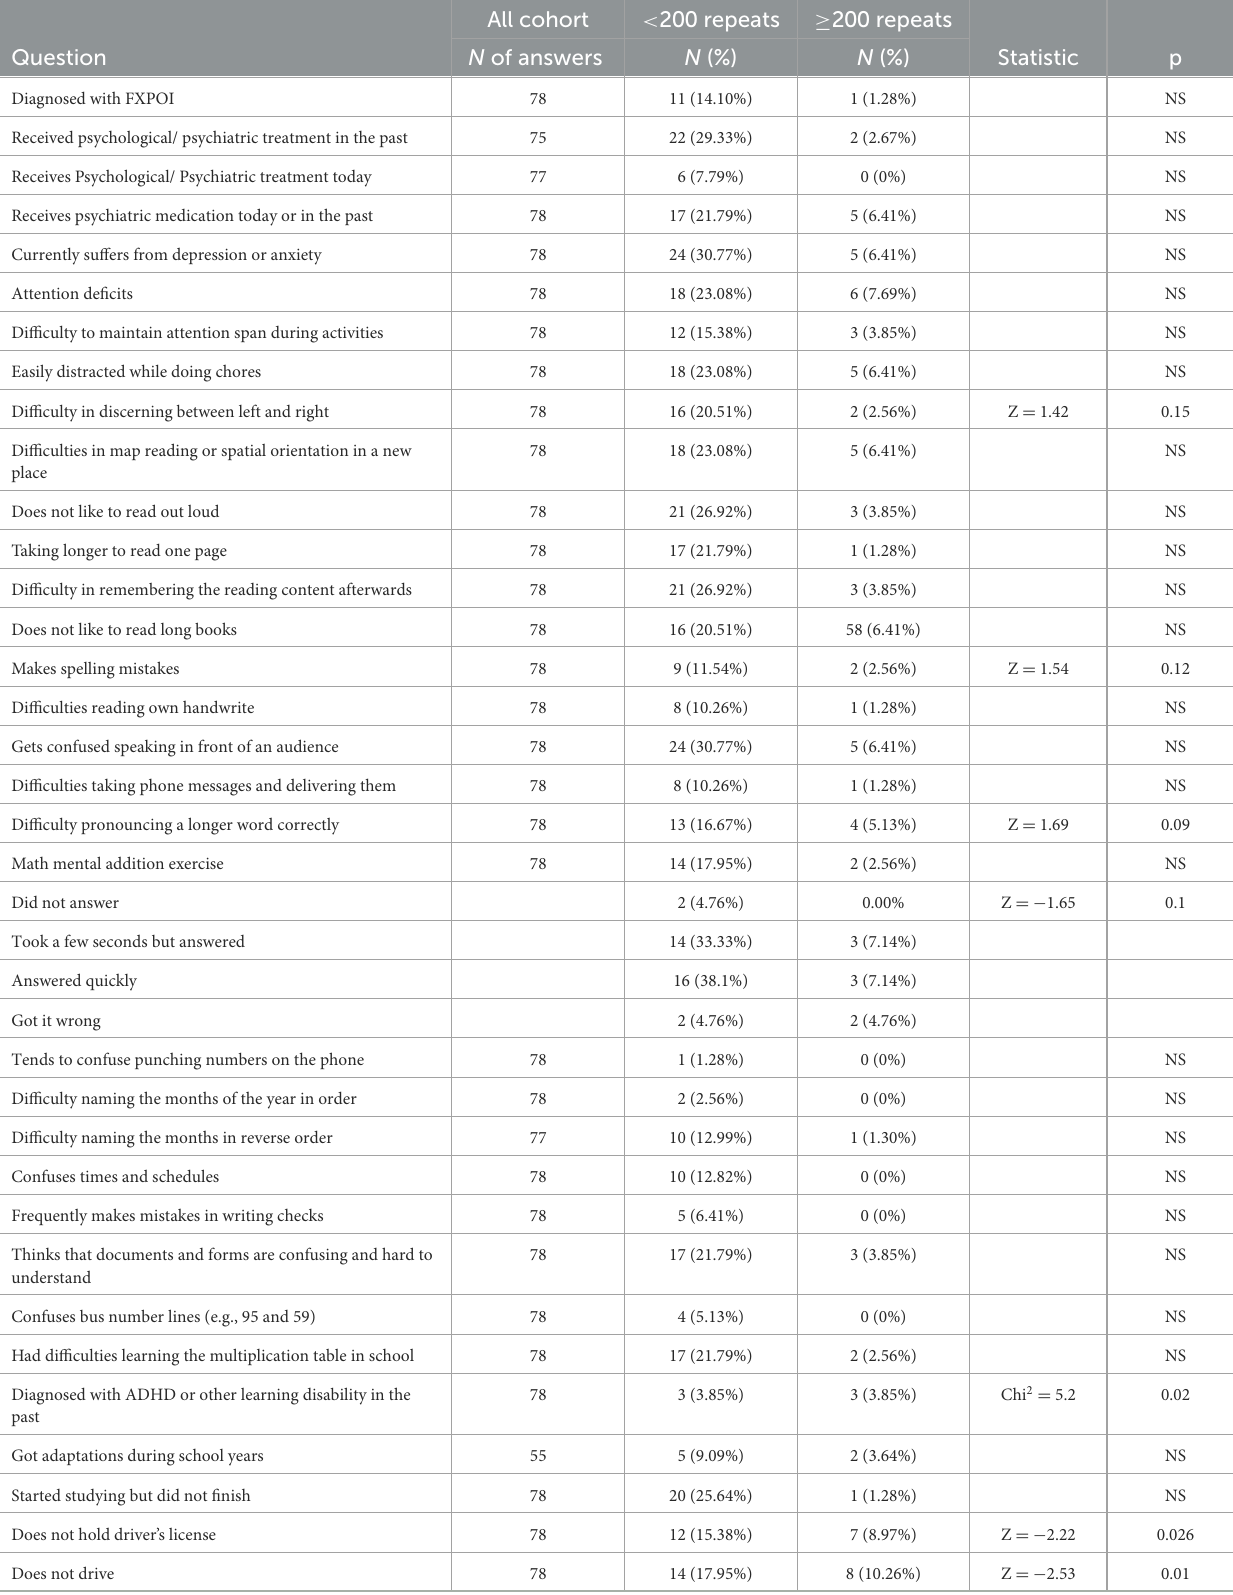
TABLE 1 Comparisons of full-scale repeats or categorical comparisons ( < or ≥ 200 repeats, NS, non-significant difference) using Pearson’s and Wilcoxon tests (Chi-square and Z approximation, respectively). All cohort < 200 repeats ≥ 200